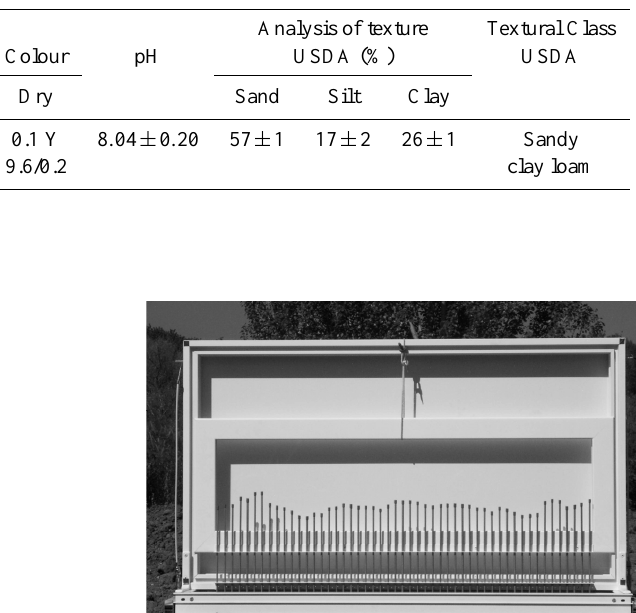
Table 1. Properties of soil.